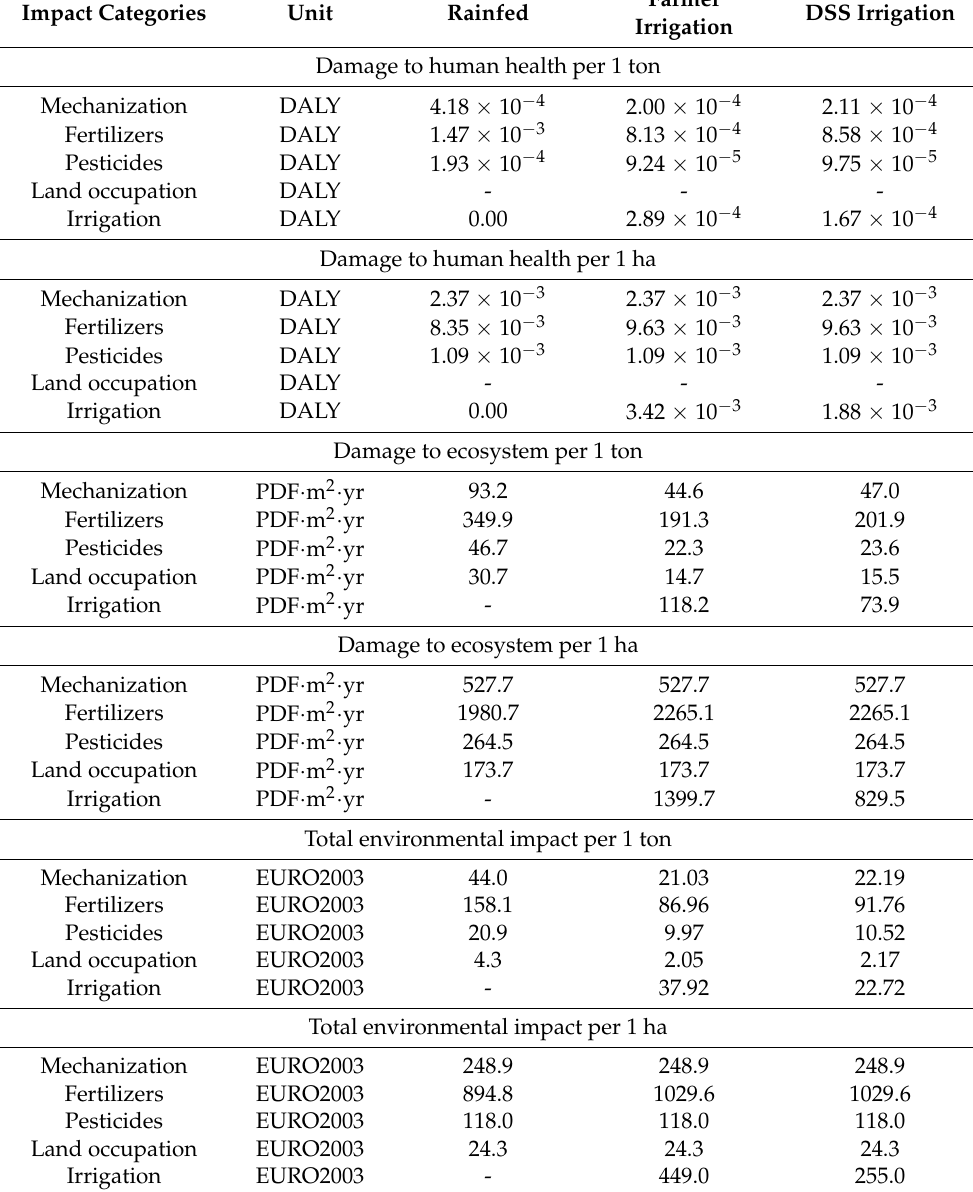
Table A3. Endpoint and single scores indicators of 1 ha of olive cultivation in the plain of Arta under different management strategies.